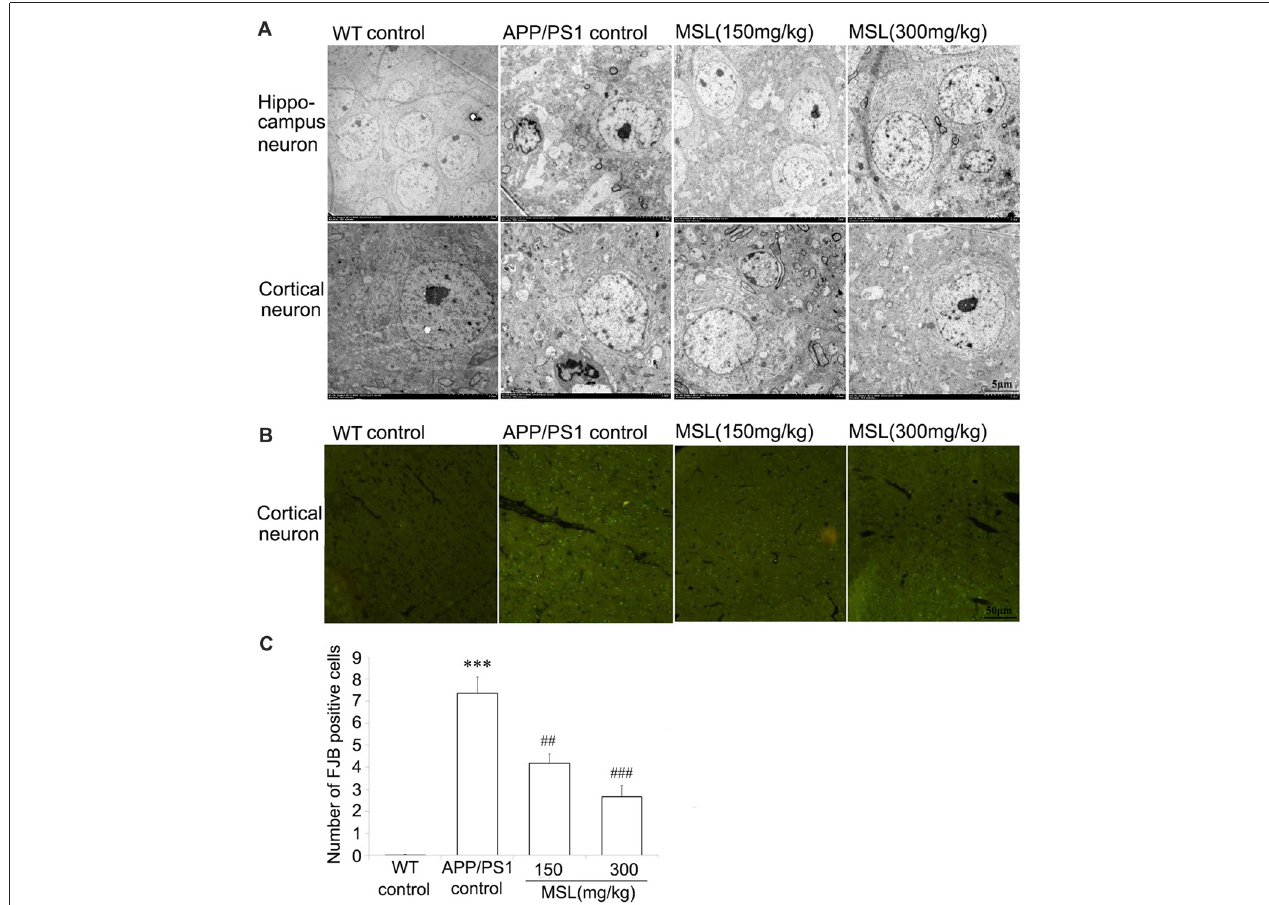
FIGURE 2 | MSL protected ultrastructural neuronal damage and degeneration. (A) Ultrastructural analysis indicated that MSL treatment prevent rupture of the neuronal membrane and edema of neurons in the hippocampus or cortex. (B) Fluoro-Jade B (FJB) staining assay was used to evaluate the effects of MSL treatment on cortical neuronal degeneration. MSL treatment significantly prevented the generation of FJB-positive cells. (C) Mean number of FJB-positive cells/mm 2 of the cerebral cortex. Data are presented as the mean ± SEM, n = 6 mice per group. ∗∗∗ p < 0.001 vs. WT control mice; ## p < 0.01, ### p < 0.001 vs. APP/PS1 control